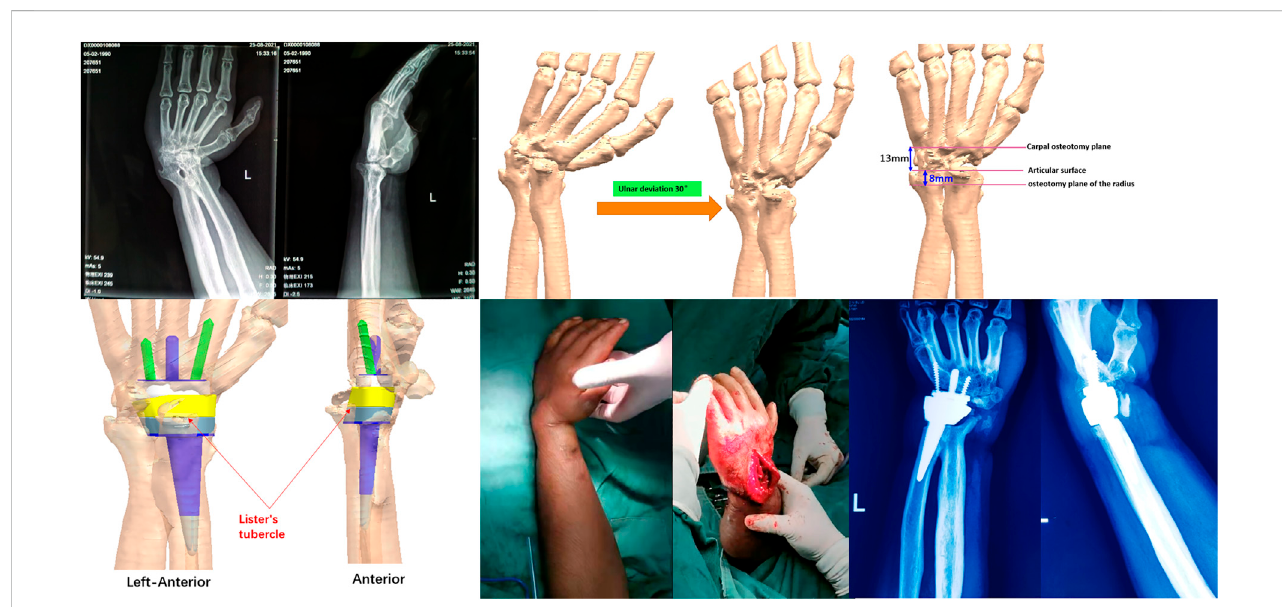
FIGURE 6 A complicated case with non-development of the carpal bones owing to a donkey bite at the age of 3 years. The patient demonstrated loss of wrist and forearm movement, but experienced pain relief and could move the wrist following personalized total wrist arthroplasty.